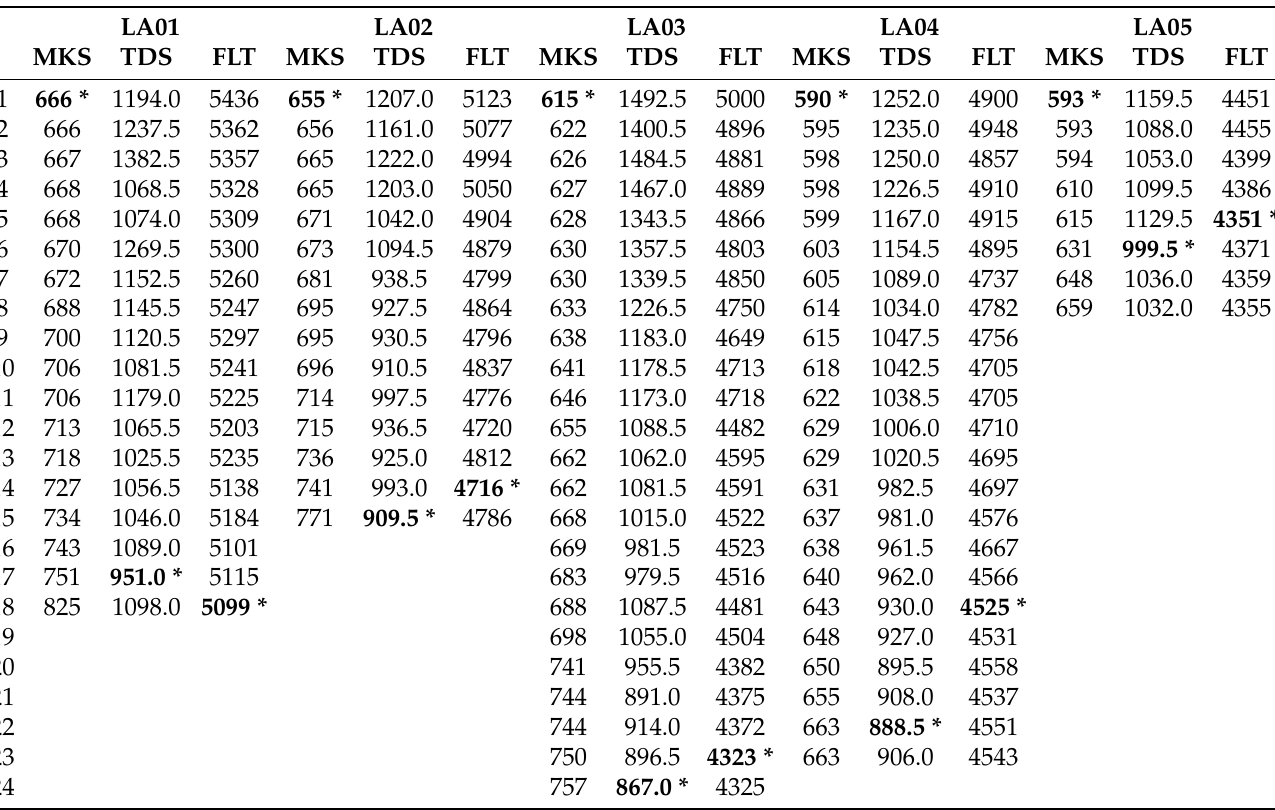
Table A3. Non-dominated front obtained by CMOSA for the JSSP instances proposed by